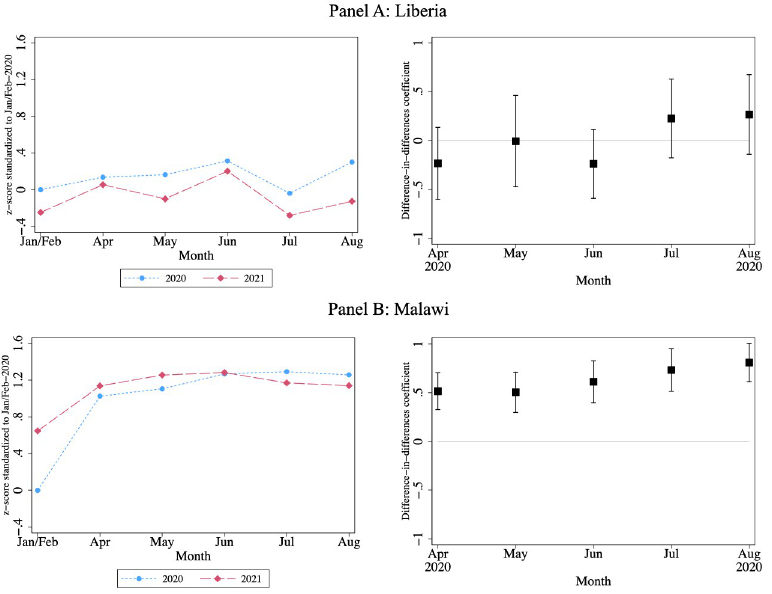
Fig 2. Household food security index (z-score). Note: Food Security Index is a standardized z-score of HDDS, FCS, and HHS (negatively weighted), using inverse covariance weighting [6] with the mean and standard deviation